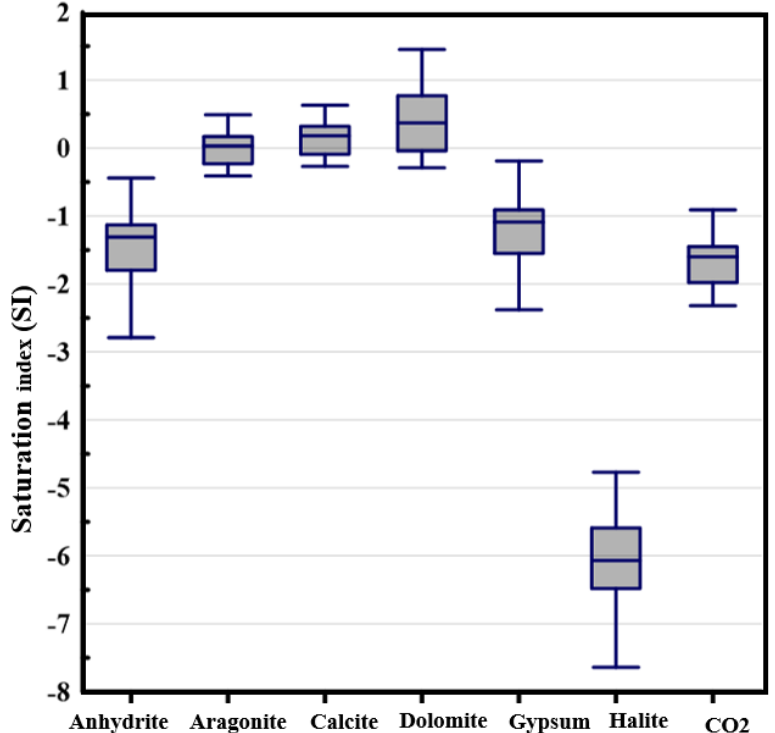
Figure 13. Box plot of the SI results for the Quaternary aquifer in the study area.